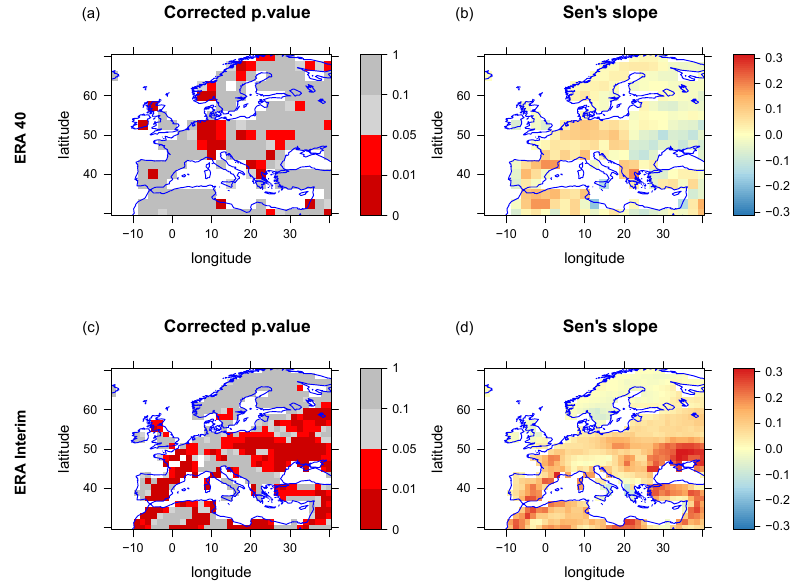
Figure 3. Trend of March–September mean FWI calculated using the ERA-40 data set for 1960–1999 (b) and the ERA Interim data set for 1980–2012 (d) . The statistical significance ( α) is shown at levels 0.01, 0.05 and 0.1 for ERA-40 (a) and ERA Interim (c) .